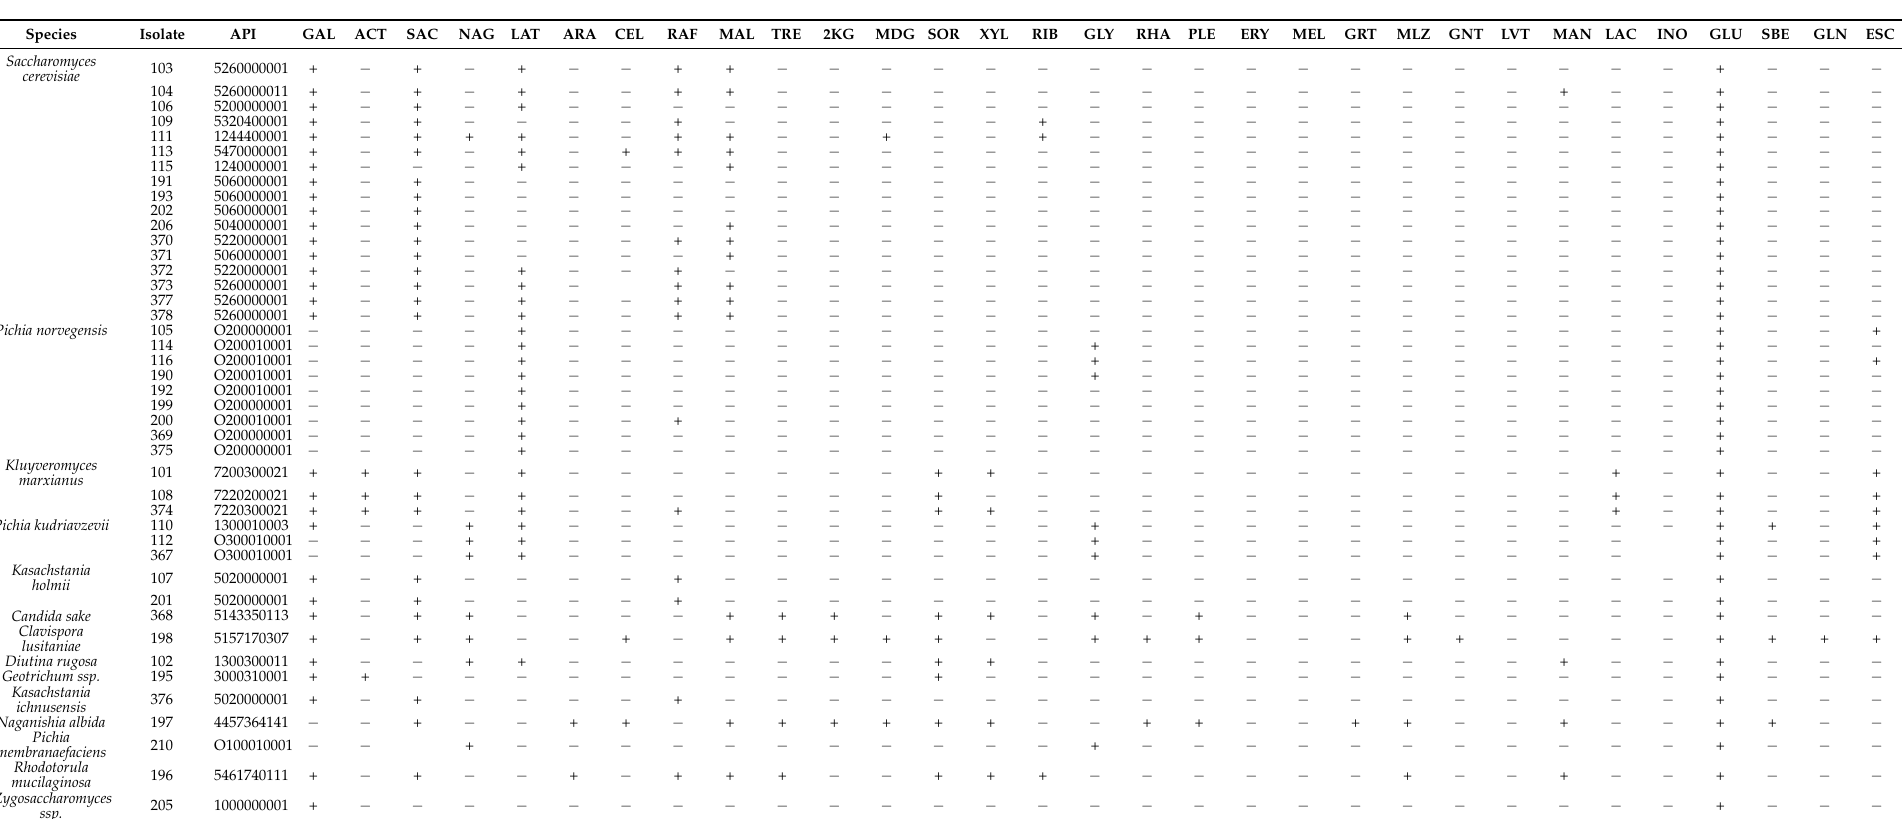
Table A1. Yeast identification based on sugar utilization as tested using the API ID 32C, showing the API identification code that resulted in the strain identification at the apiweb (BioM é rieux)